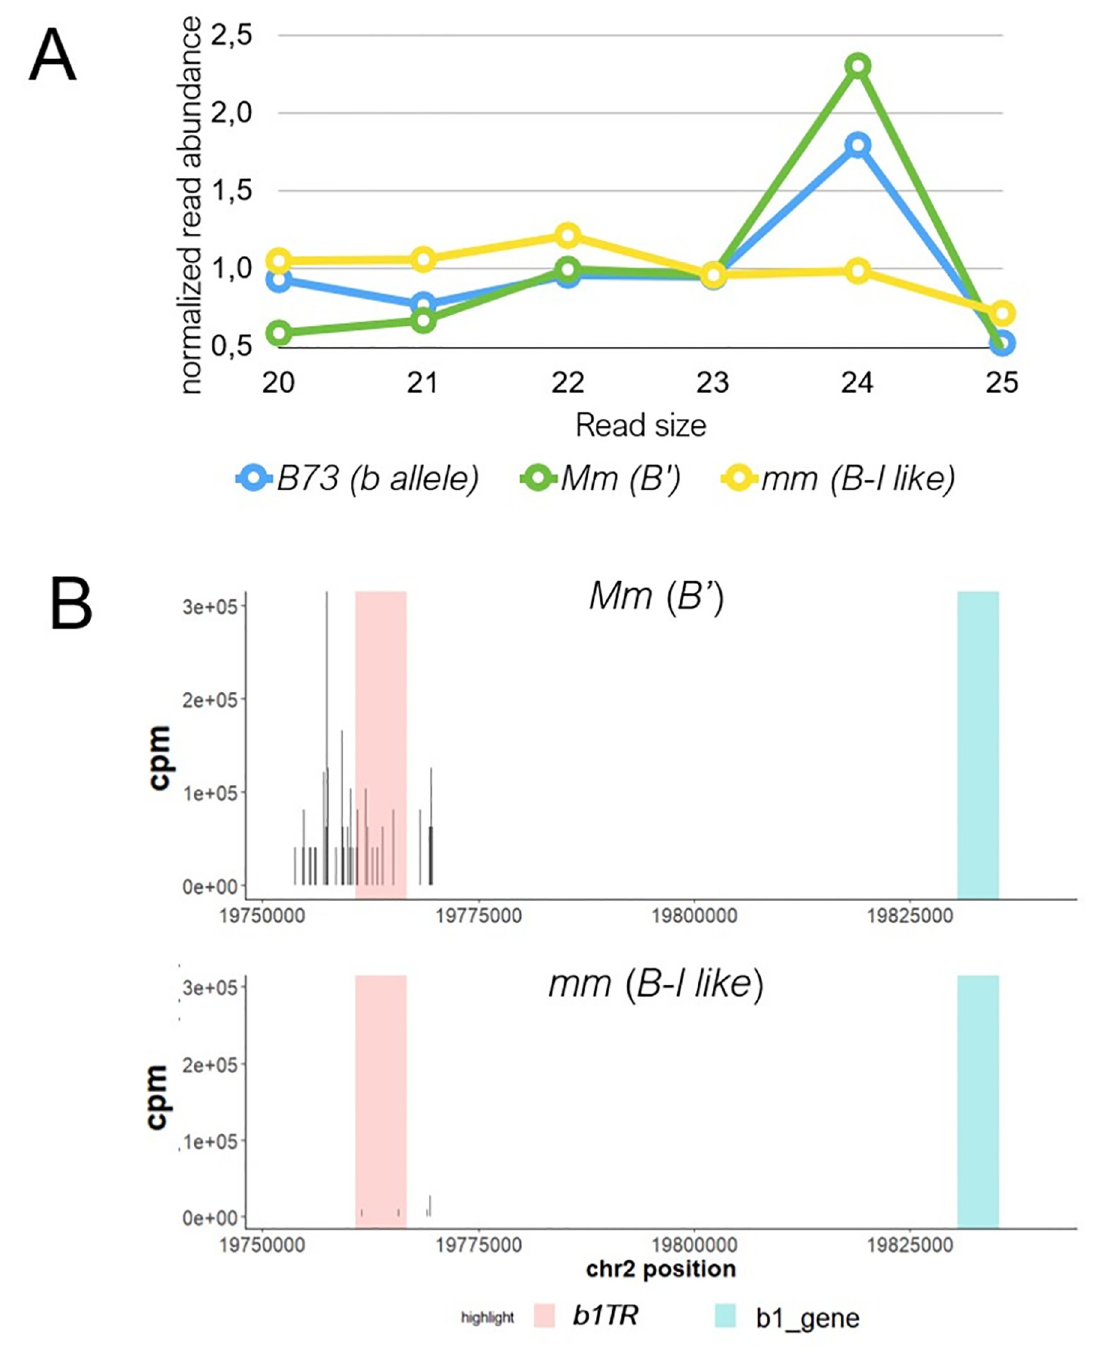
Fig 2. RNA-IP sequencing (RIP-seq) of AGO104-loaded small RNAs in mature ears of B73 ( b ), Mm ( B’ ) and mm ( B-I like ) individuals. A) Size distribution of reads normalized to 1. B) Distribution of 24-nt reads within the 100-kb region that includes the b1TR (red box) and the b1 gene (blue box). x axis shows the B73/ b1TR s composite reference map used for aligning reads. Vertical black bars indicate normalized read counts (CPM: Counts Per Million).